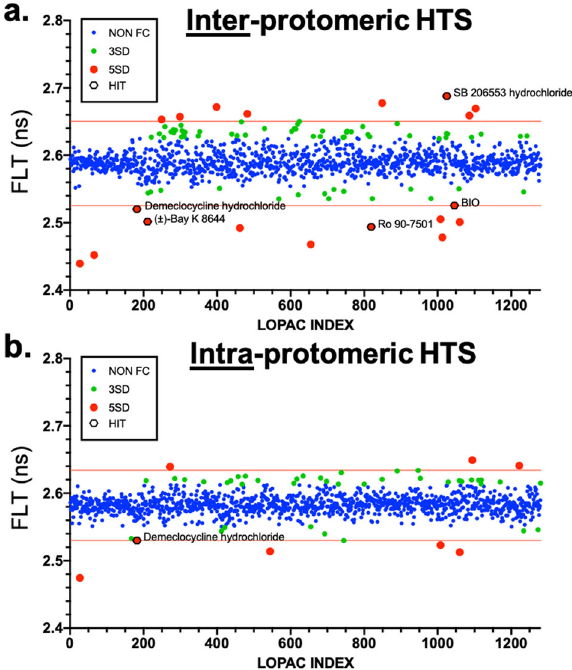
Fig. 5 Pilot HTS on cellular α SN FRET biosensors. a , b Screens of the 1280-compound LOPAC library were performed in a single 1536- well plate for both the inter-protomer ( a ) and intra-protomeric ( b ) biosensor. Pilot HTS provided 19 and 8 hits, respectively, that changed FLT by >5 SD (red). For some systems, a 3-SD (red + green) threshold is suf fi cient if secondary assays can process the increased throughput.